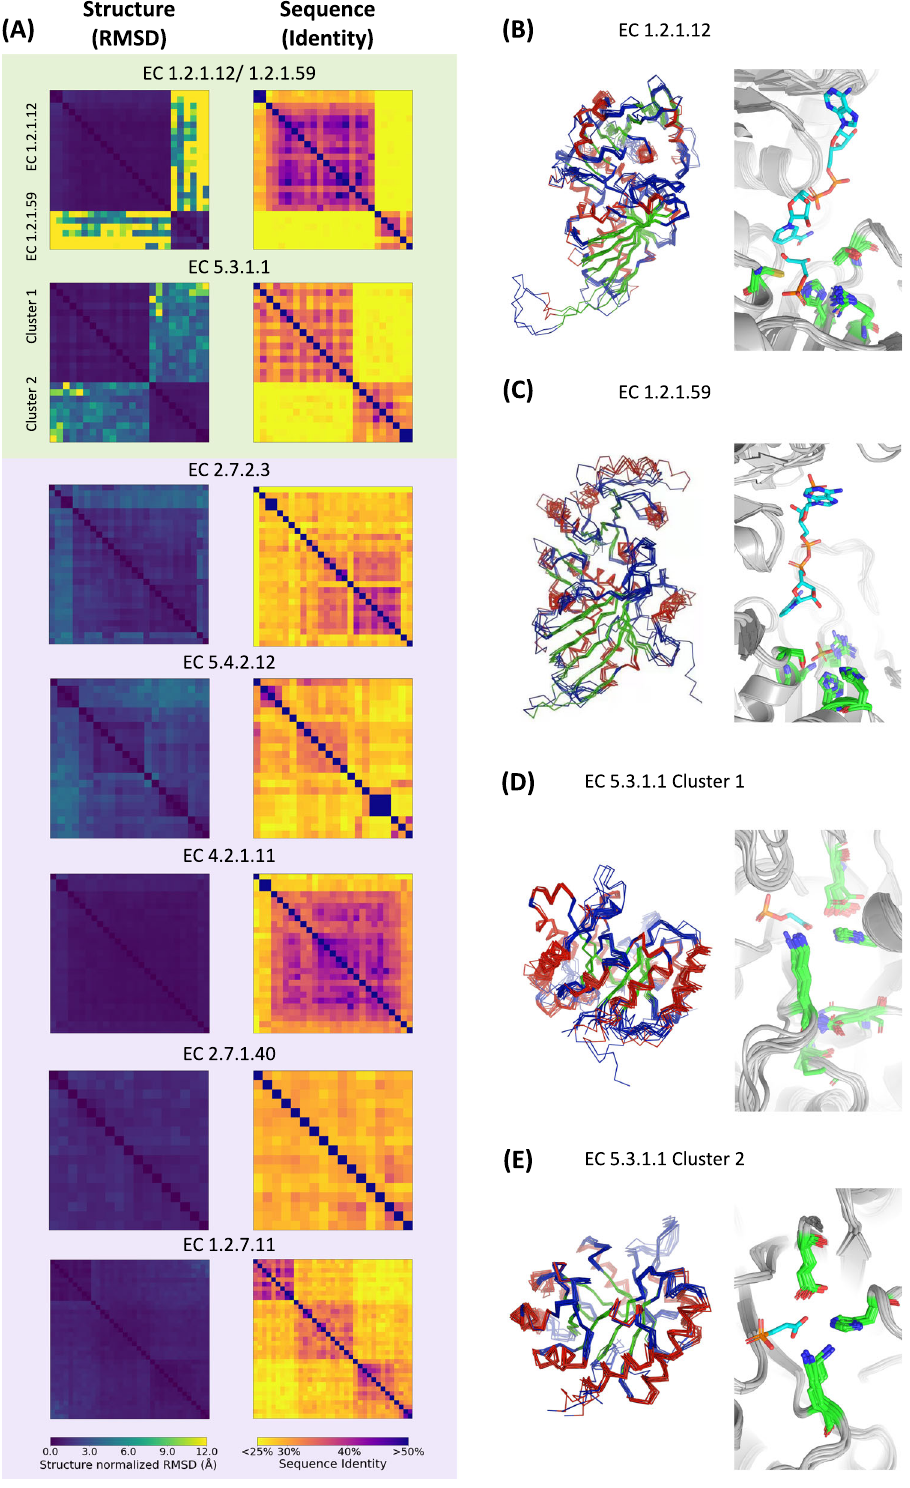
Fig. 4 | Comparison of seven key enzymes in the glycolysis/gluconeogenesis pathway among A501, 3DAC, and 12 other archaeal and 12 bacterial strains in different positions across the phylogenetic tree. A Similarity of sequences and structures of seven key enzymes. Superposition predictions of protein structures (left) and reactive sites (right) in the same cluster of proteins with the enzyme classi fi cation (EC) number: EC 1.2.1.12 ( B ), EC 1.2.1.59 ( C ) and EC 5.3.1.1 group 1 ( D )